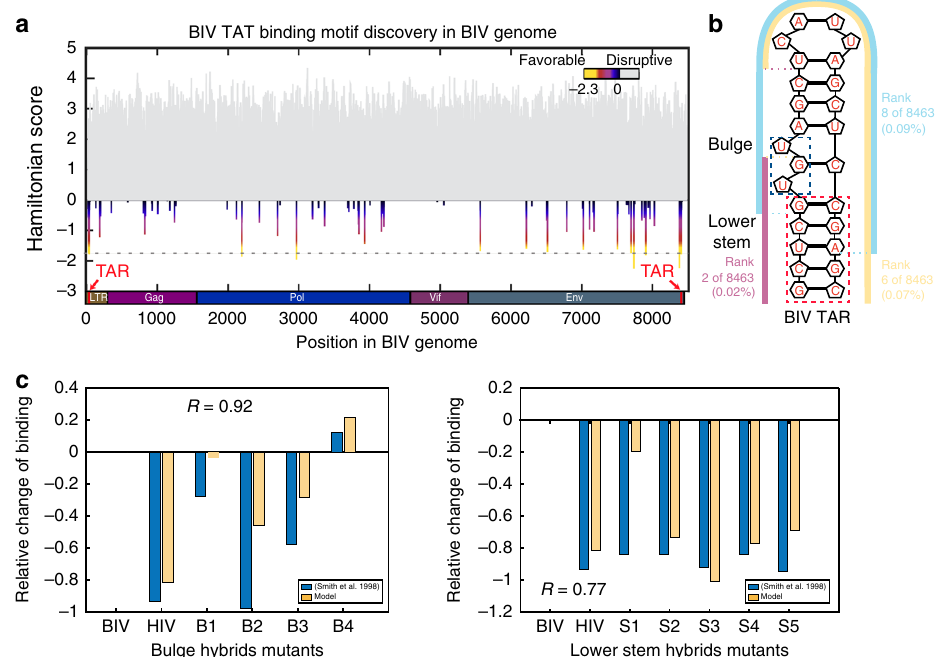
Fig. 5 The BIV DCA-scape accurately predicts mutational outcomes. a Identi fi cation of trans-activating regions in the BIV genome (red arrows and dotted line indicate the positions of the binding elements). b The secondary structure of the BIV TAR RNA. The lower portion of the element containing an essential bulge has the most favorable Hamiltonian score. c A comparison of mutational assays in the TAR bugle (left, Pearson ’ s R = 0.93) and lower stem (right, Pearson ’ s R = 0.77) to Hamiltonian scores